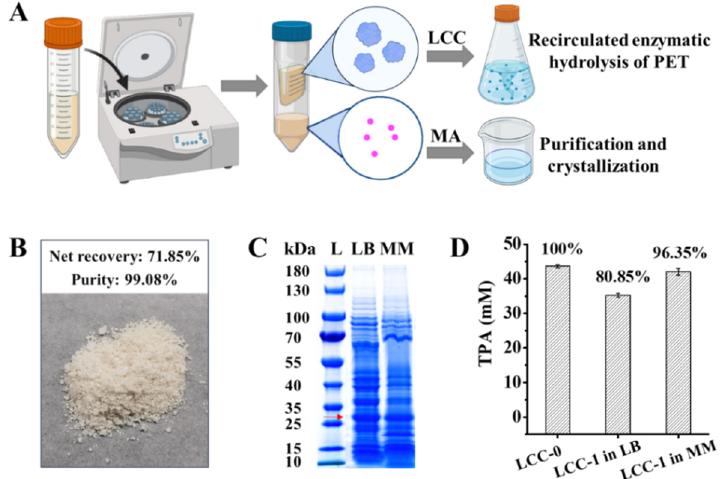
Figure 5. Separation of LCC from MA and used for the new round of hydrolysis of PET. ( A ), The process for separating the end product MA and the reproduced LCC; ( B ), recovery rate and purity of the obtained MA powder; ( C ), SDS-PAGE analysis of the crude enzyme produced when the bioconversion of PET hydrolysates occurred concurrently in LB or mineral medium (MM). There is a clear thickened band at the size of LCC (approximately 27.8 kDa); ( D ), activity comparison of LCC crude enzyme form different resources. LCC-0, crude enzyme produced from LB without bioconversion of PET hydrolysates; LCC-1 in LB, crude enzyme produced from LB when the bioconversion occurred concurrently; LCC-1 in MM, crude enzyme produced from MM when the bioconversion occurred concurrently. Error bars indicate the standard deviation based on duplicate parallels.